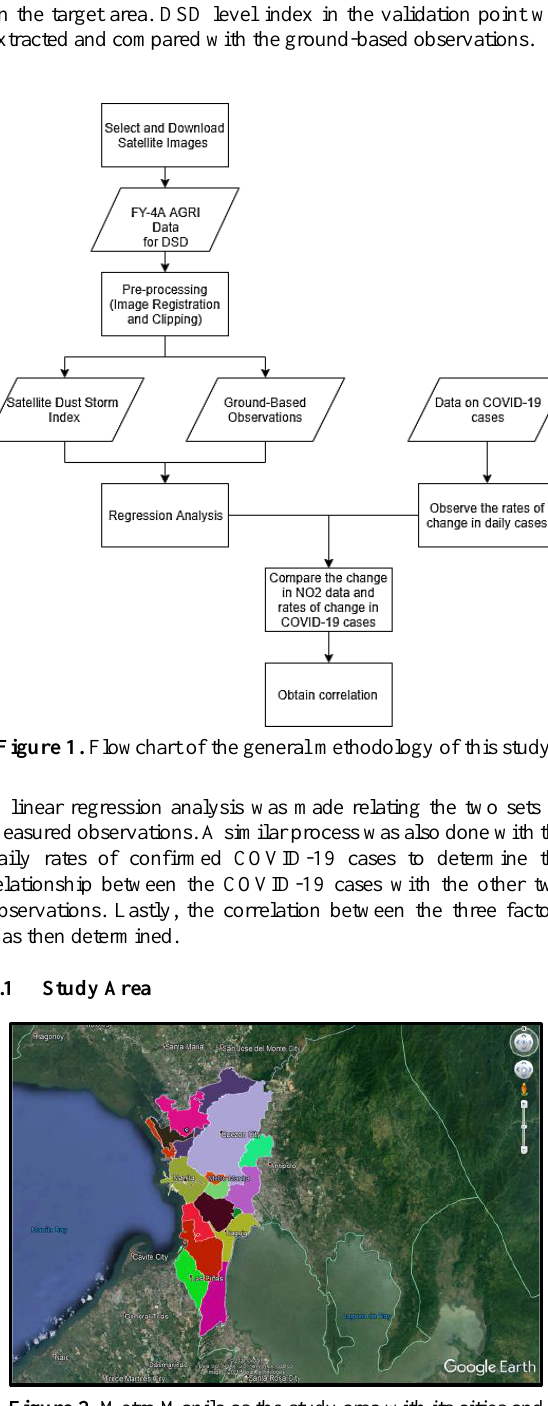
Figure 2. Metro Manila as the study area with its cities and municipality represented in colored polygons as overlaid in Google